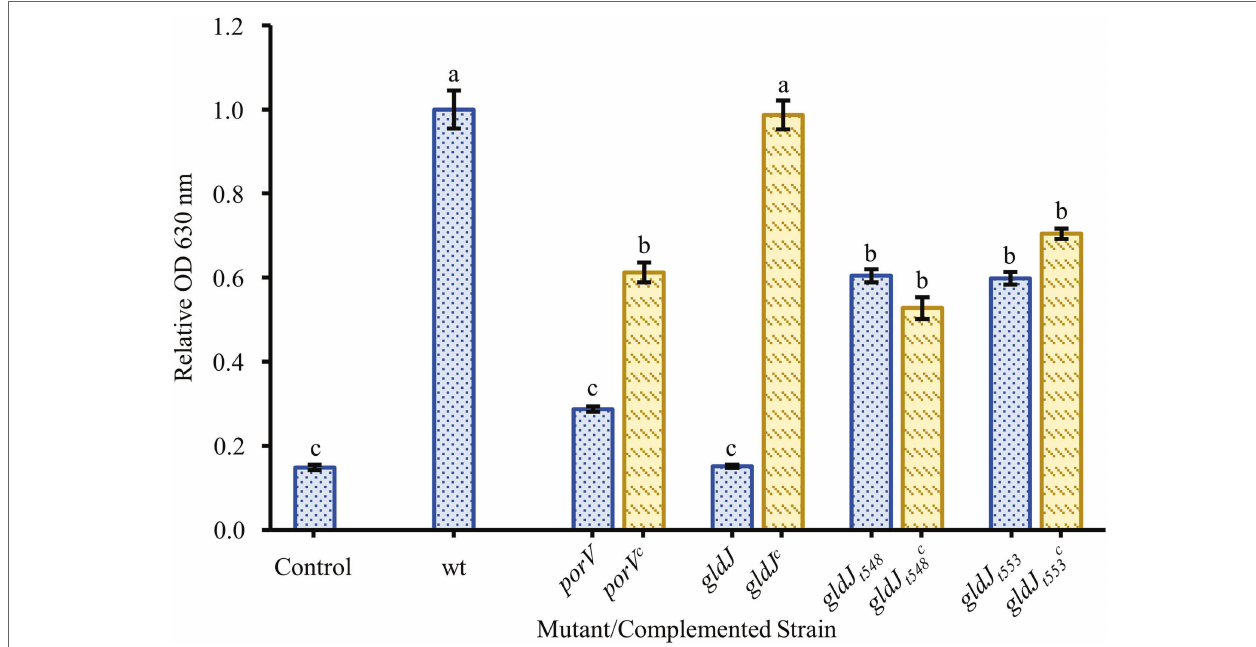
FIGURE 5 | Biofilm formation by non-motile, T9SS-competent mutants and motile, T9SS-deficient mutants. Biofilm formation was determined for strains with knockouts in genes resulting in the loss of T9SS function ( porV ), motility (g ldJ t548 and gldJ t553 ), and both T9SS and gliding motility ( gldJ ). Knockouts (blue-dotted bars) and complemented knockouts (yellow-dashed bars) of F. johnsoniae were porV and porV c : CJ2130 and CJ2169; gldJ and gldJ c : UW102-55 and CJ1111; gldJ t548 and gldJ t548c : CJ2386 and CJ2405; and gldJ t553 and gldJ t553c : CJ2443 and CJ2484. Results are reported as relative OD values (averages of at least four replicates; normalized to the wild type). Error bars indicate 95% CI. Different letters above the error bars represent different significance groups (one-way ANOVA followed by Tukey test, value of p =